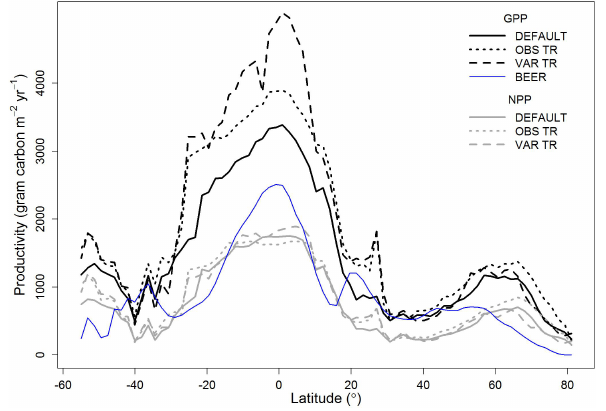
Fig. 3. Latitudinal gradient of median GPP and NPP (gram car- bon m − 2 yr − 1 ) for default simulation (DEFAULT), observed traits simulation (OBS TR) and variable traits simulation (VAR TR), and GPP taken from Beer et al. (2010) (BEER). Table 3. Dominant PFT coverage (%) of vegetated grid cells for the three different simulations. % coverage of dominant PFT Observed Variable PFT Default traits traits simulation simulation simulation Tropical evergreen trees 23.06 Fig. 4. Latitudinal gradient of mean trait values weighted by frac- tional cover of the PFTs. (a) SLA (m 2 kg − 1 carbon), (b) Vcmax 25 (µmolm − 2 s − 1 ), and (c) Jmax 25 (µmolm − 2 s − 1 ). For Jmax 25 , C4 grasses are left out as PEP instead of Jmax 25 is modeled for this PFT. Lines and abbreviations as in Fig.